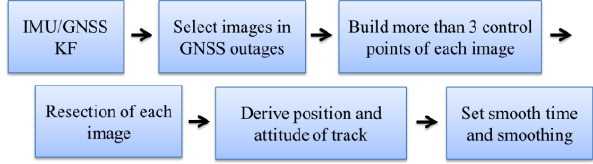
Figure 13: The process of control point feedback